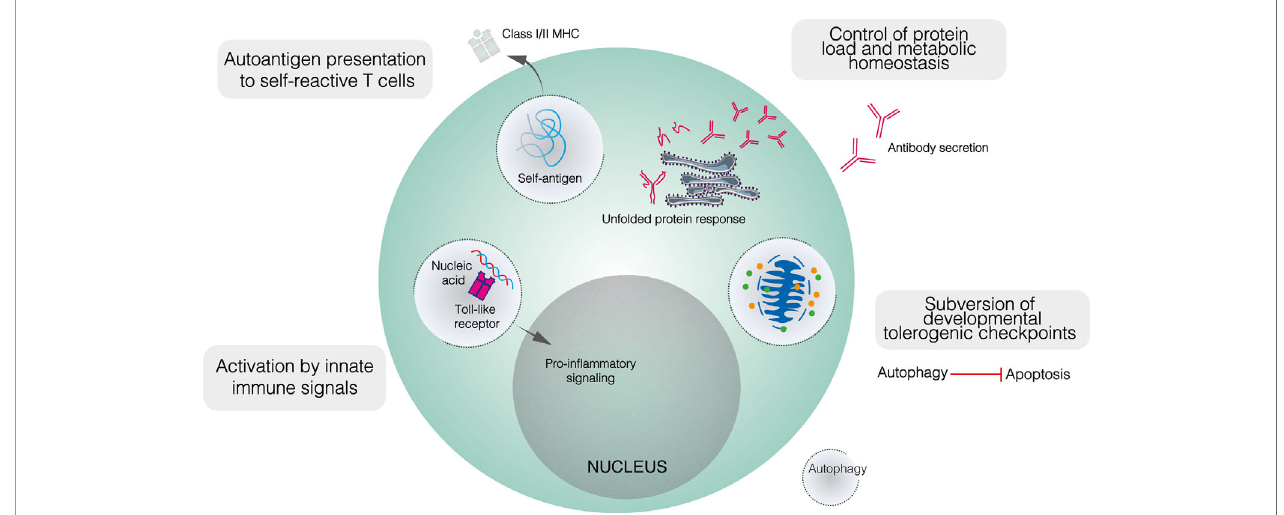
FIGURE 3 | The role of autophagy in the function of self – reactive B cells. Developmentally, upregulated autophagy is thought to enable autoimmune B cell precursors to subvert apoptotic checkpoints. In mature B cells, autophagy appears to mediate both the presentation of self – peptides by B cells, and the recognition of innate immune ligands such as nucleic acids. It is also likely that autophagy contributes to metabolic homeostasis and control of the misfolded protein load in plasma